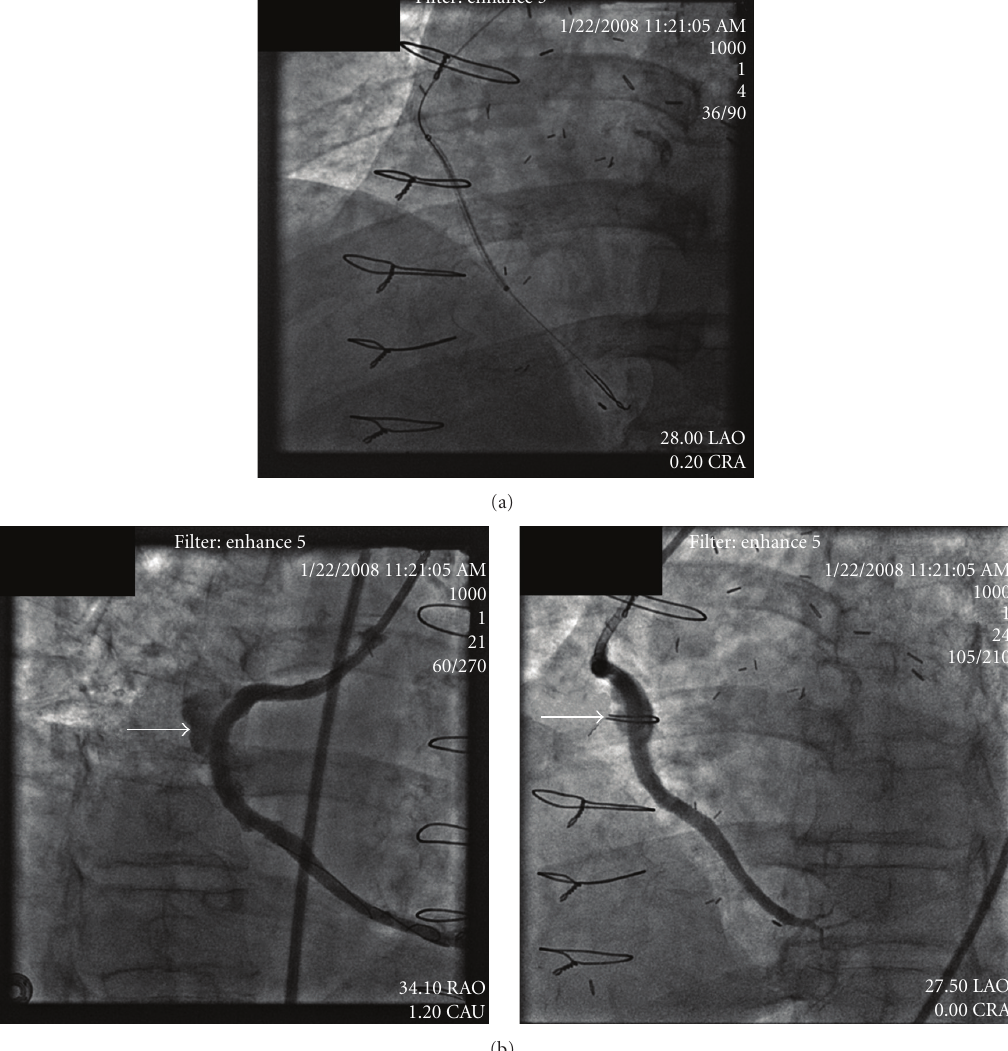
Figure 3: (a) Placement of the Viabahn self expanding stent with two guidewires in distal SVG and no guide catheter. (b) Coronary angiography after placement of the stents with residual contrast entrapped in the aneurysm (arrows) in both RAO and LAO views with TIMI 3 flow in